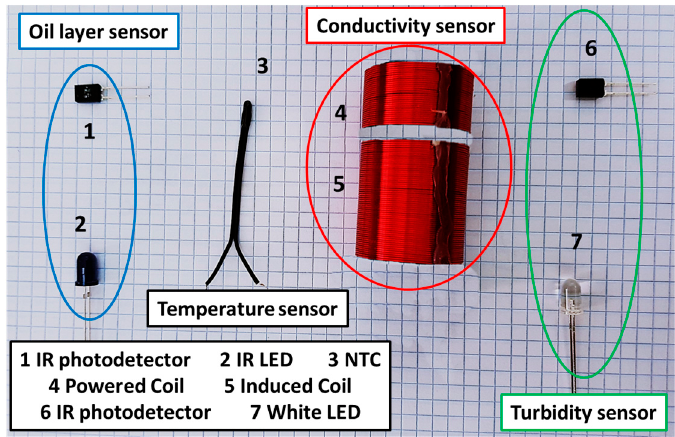
Figure 6. Employed components for sensor to monitor the water quality.